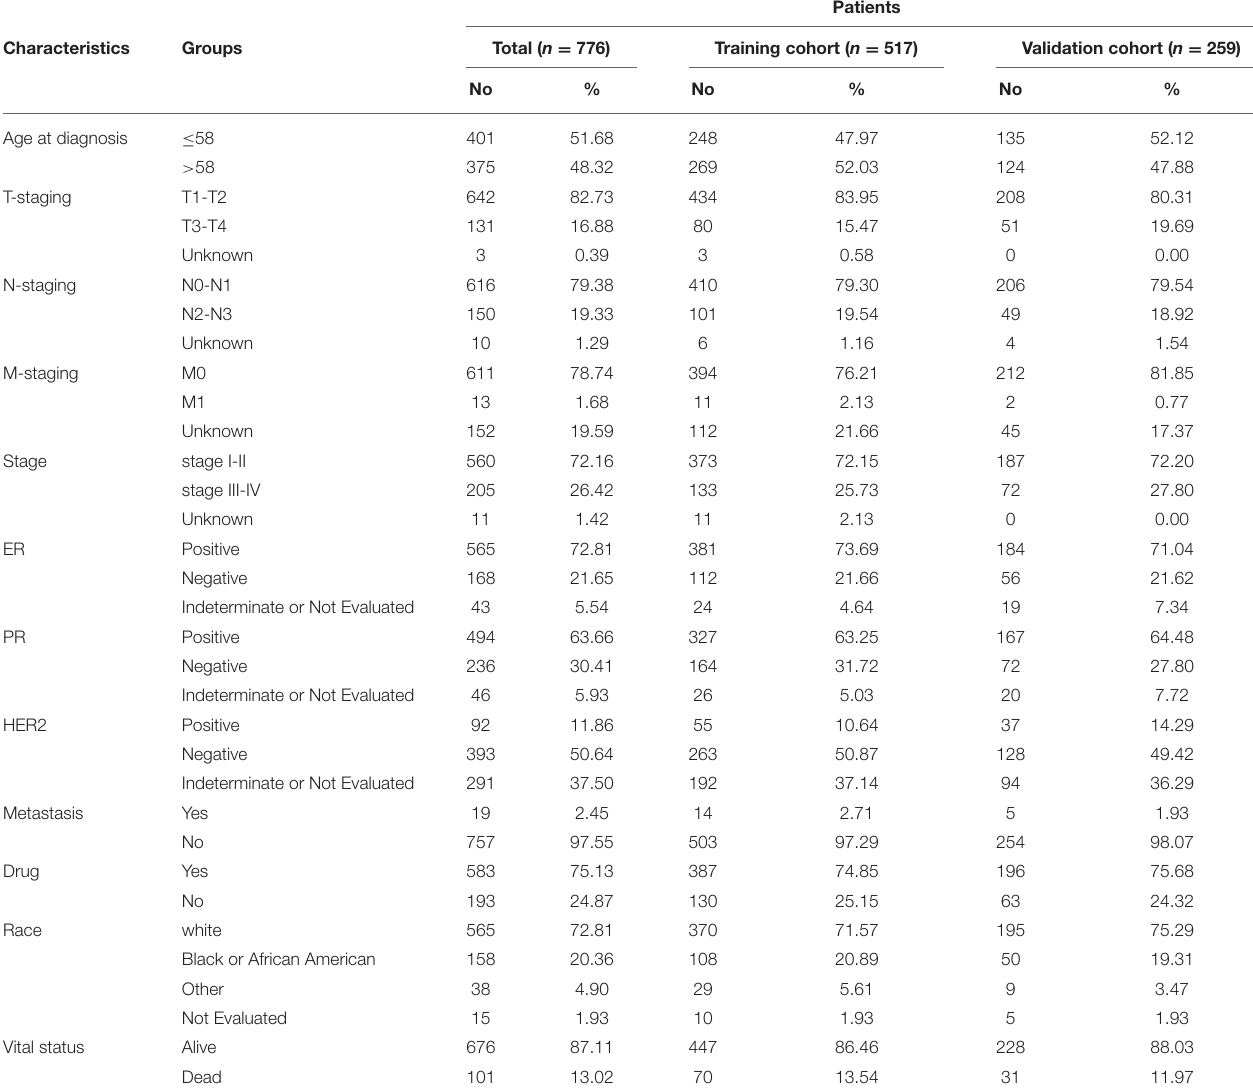
TABLE 3 | Clinicopathological characteristics of BRCA patients from TCGA database.